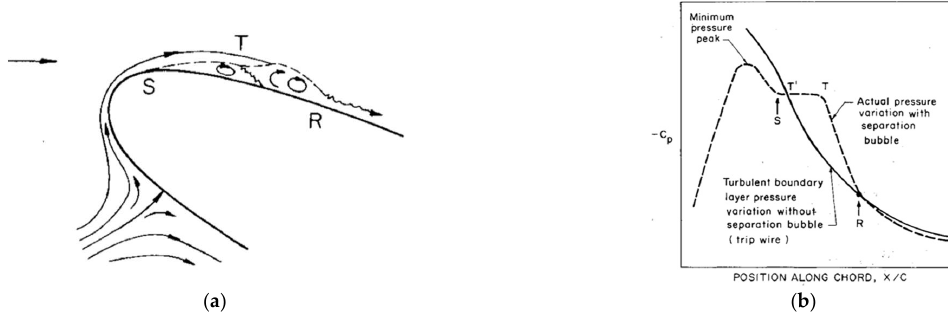
Figure 8. ( a ) Schematic representation of the separation bubble and reattachment; ( b ) typical surface pressure distribution with and without the separation bubble [42].